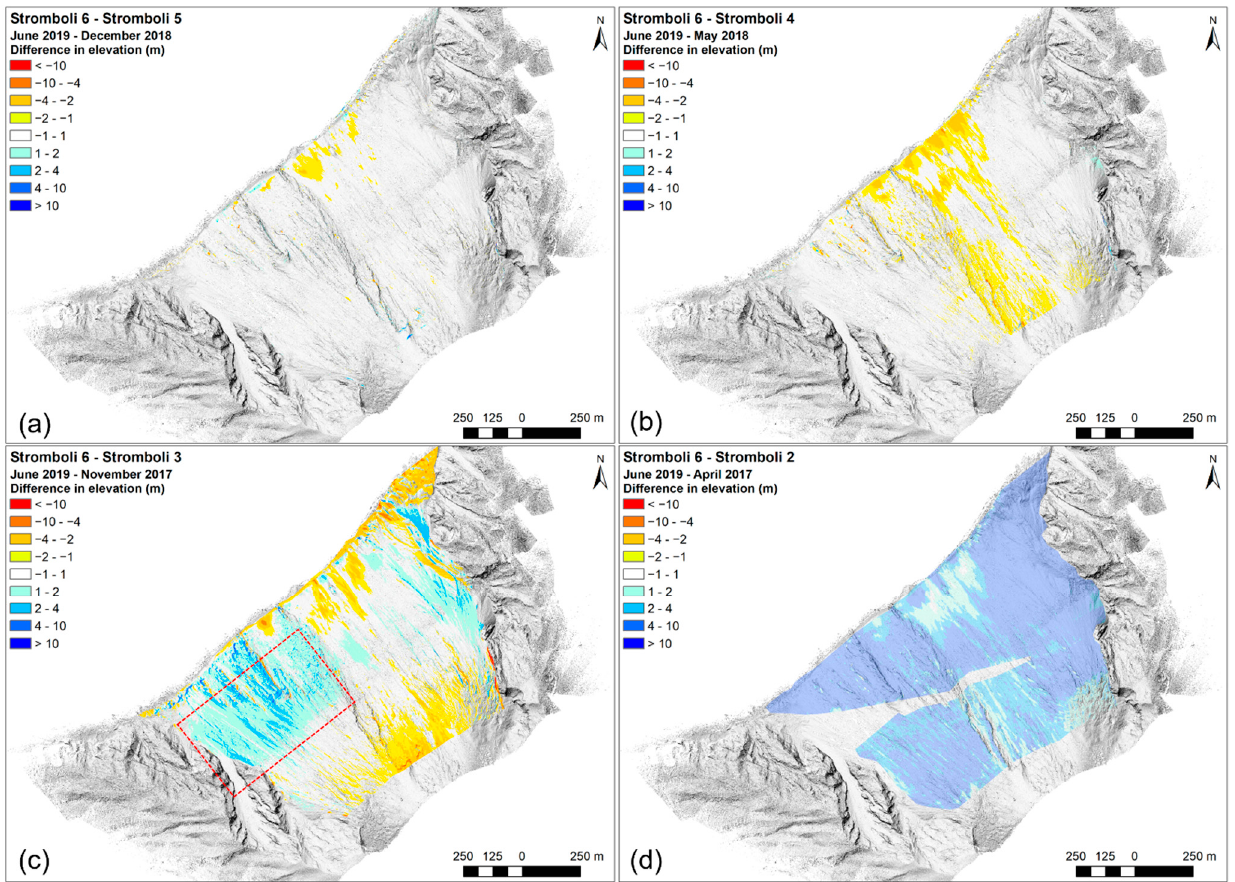
Figure 6. Difference in elevation between Digital Surface Models. ( a ) Stromboli 6–Stromboli 5; ( b ) Stromboli 6–Stromboli 4; ( c ) Stromboli 6–Stromboli 3. The area inside the red box identifies a misalignment error. ( d ) Stromboli 6–Stromboli 2.